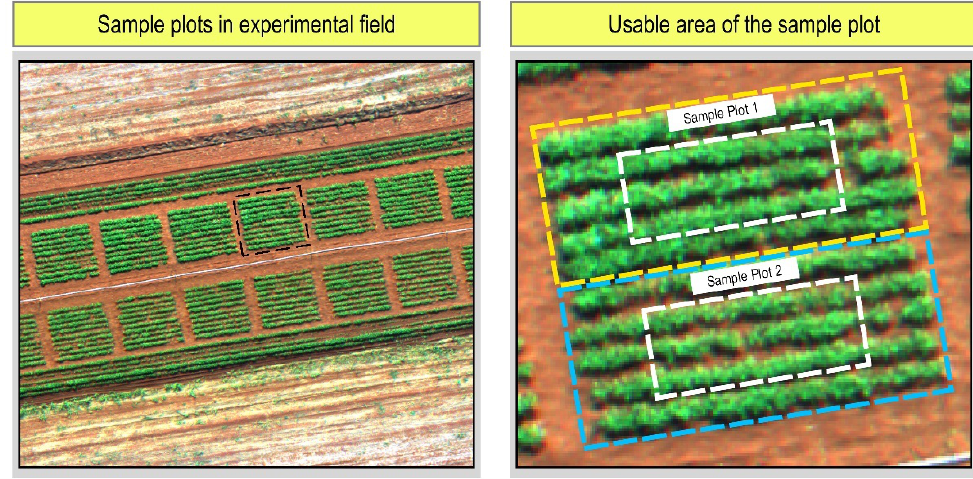
Figure 2. Sample plots in experimental field 5 × 2.25 m ( left ) and usable area of sample plots of 3 × 1.35 m ( right ). Yellow: Plot 1; Blue: Plot 2; and White: usable area of both plot 1 and plot 2.